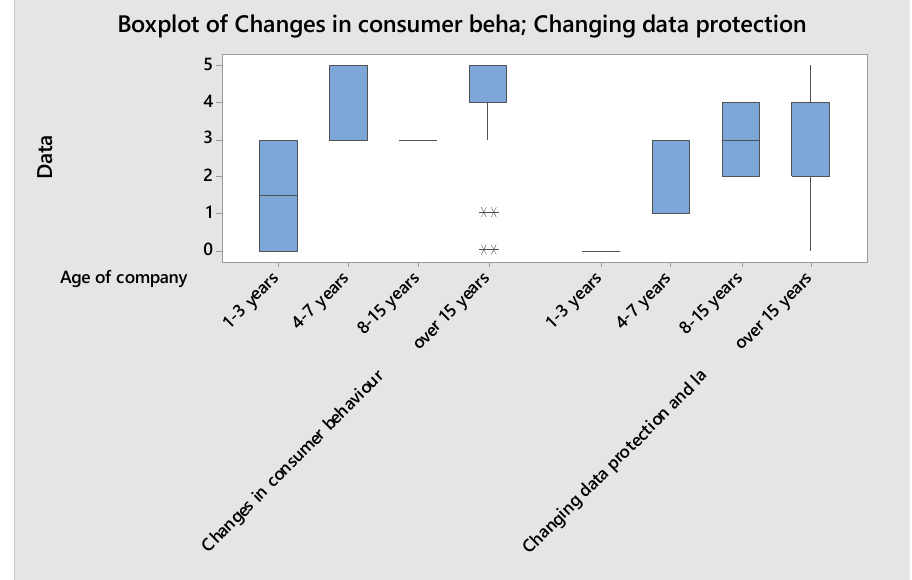
Figure 8. Box plot: comparison of the importance of the changes in consumer behavior, changing data protection, and labor regulations indicators for manufacturing companies, depending on their age. ** denotes single observations.